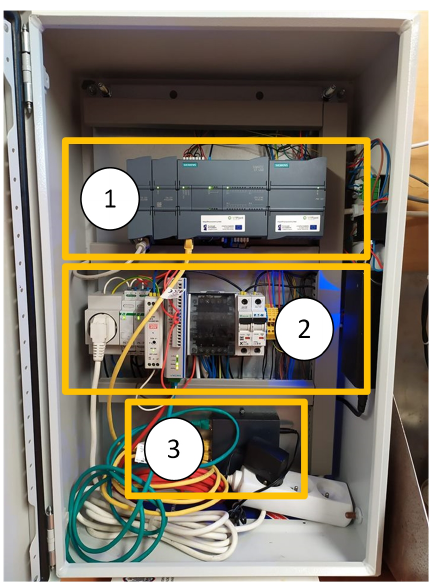
Figure 6. General view of the control cabinet 1: PLC controller, 2: power section, 3: Ethernet switch.